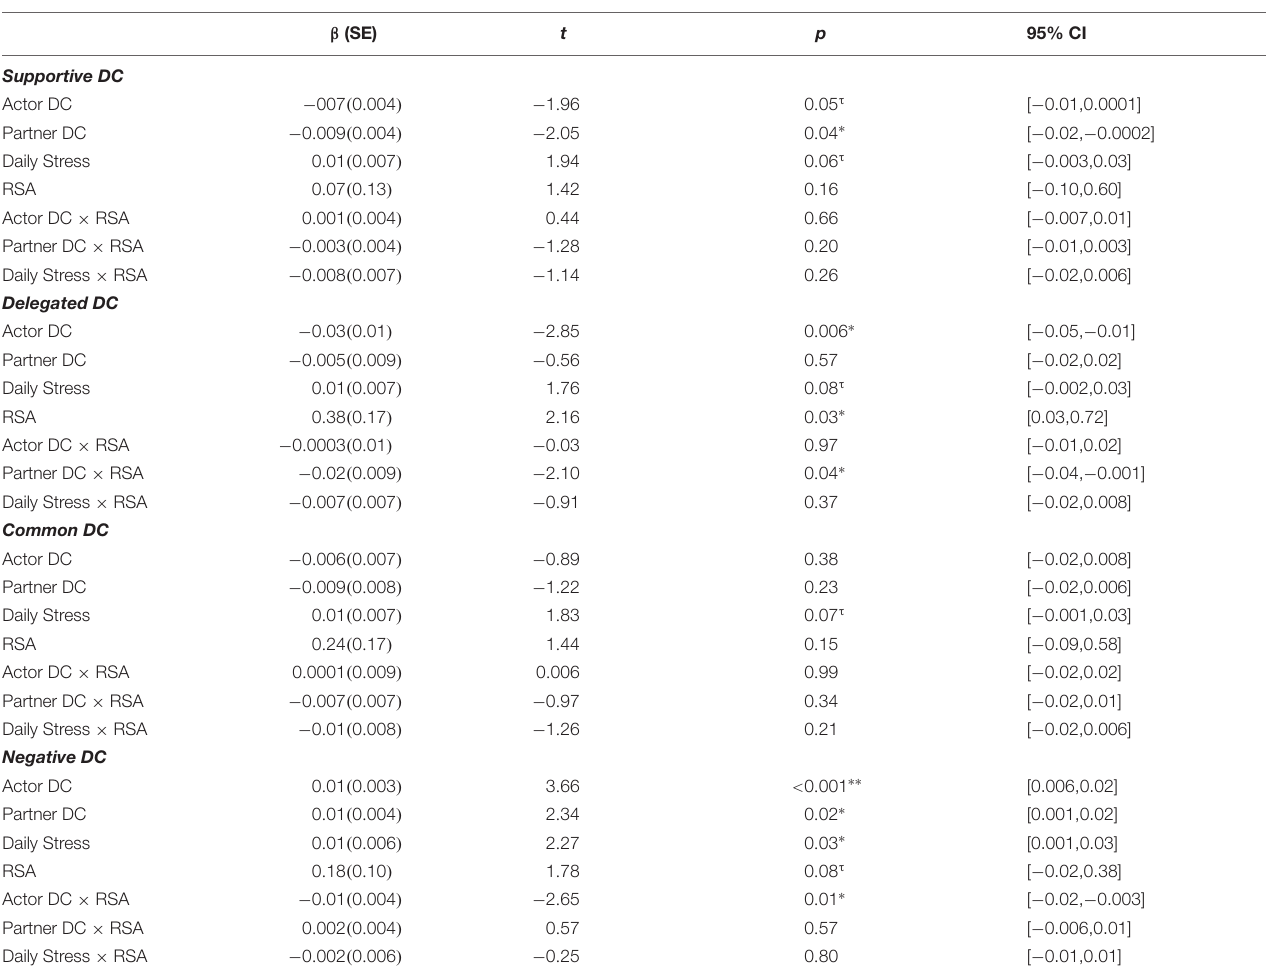
TABLE 2 | Actor and partner effects of DC on depression and moderation effects of RSA for men. β